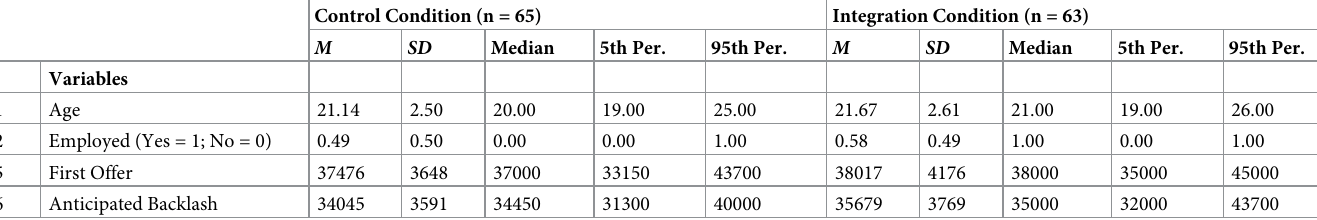
Table 2. Descriptive statistics for key variables in Study